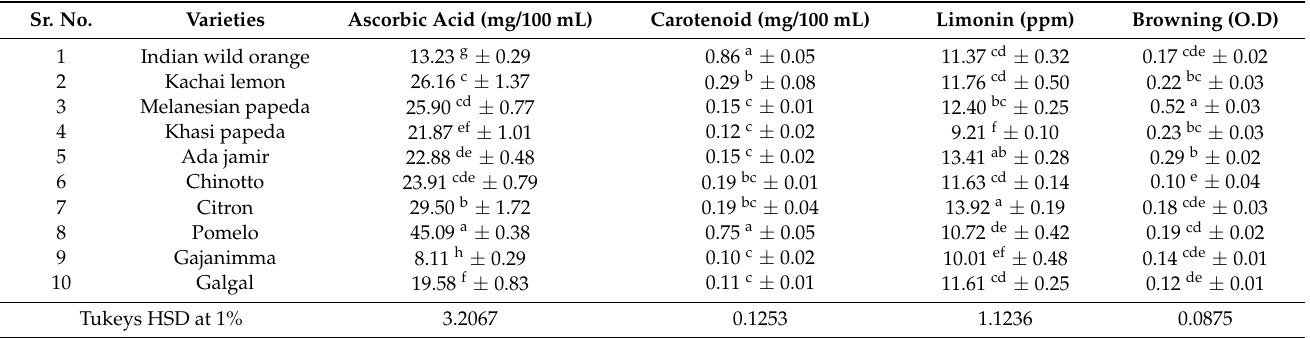
Table 1. Ascorbic acid, carotenoid, and browning content quantified in underutilized citrus varieties collected from Nokrek Biosphere Reserve, West Garo Hills, Meghalaya,